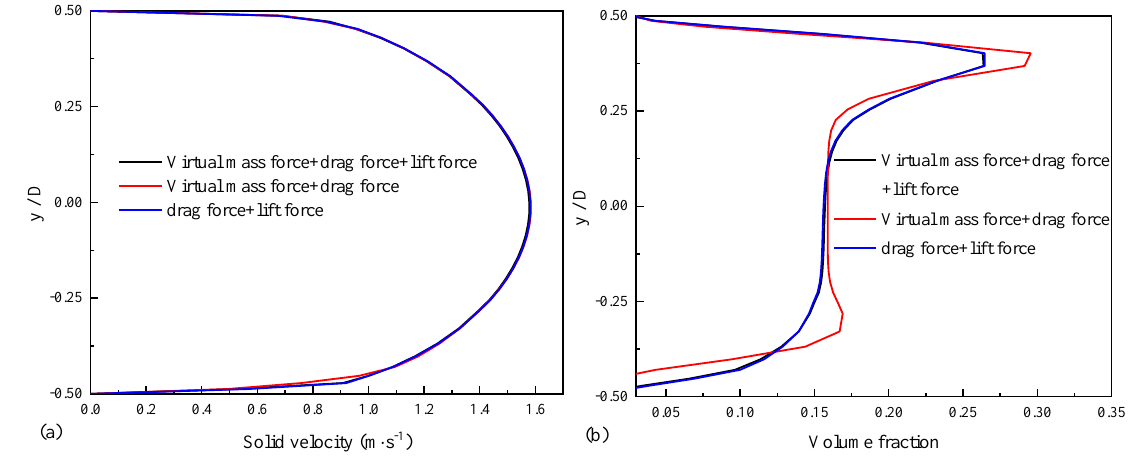
Figure 4. Distribution of Solid velocity ( a ) and IVF ( b ) at x = 1.5 m.